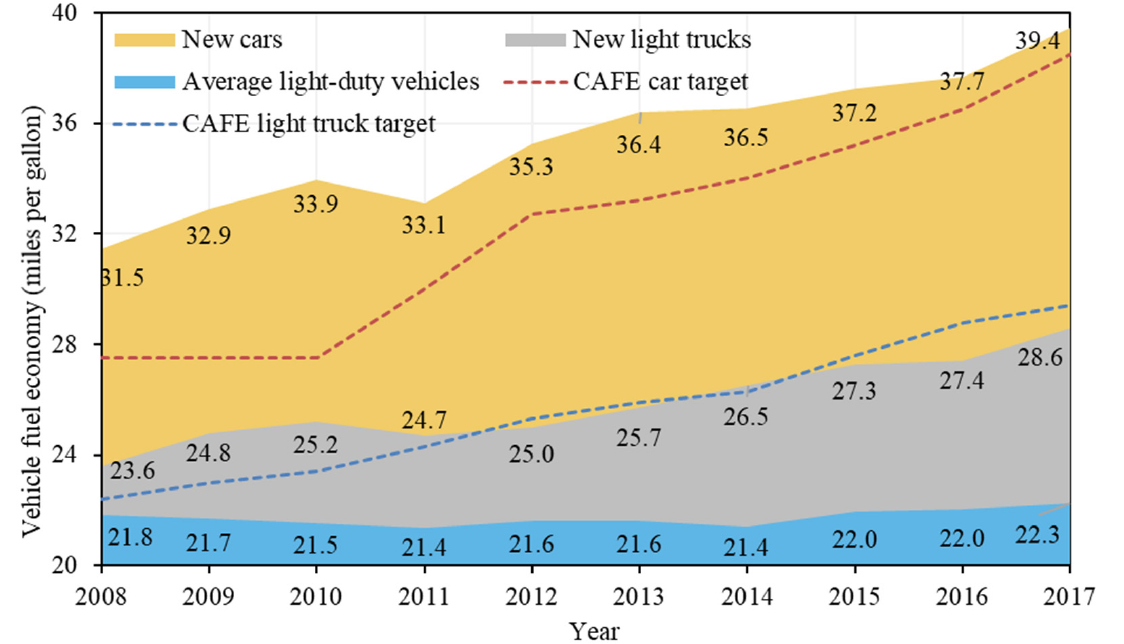
Figure 5. Fuel economy of light-duty vehicles in the U.S. from 2008 to 2017 (Source of data: [43]).